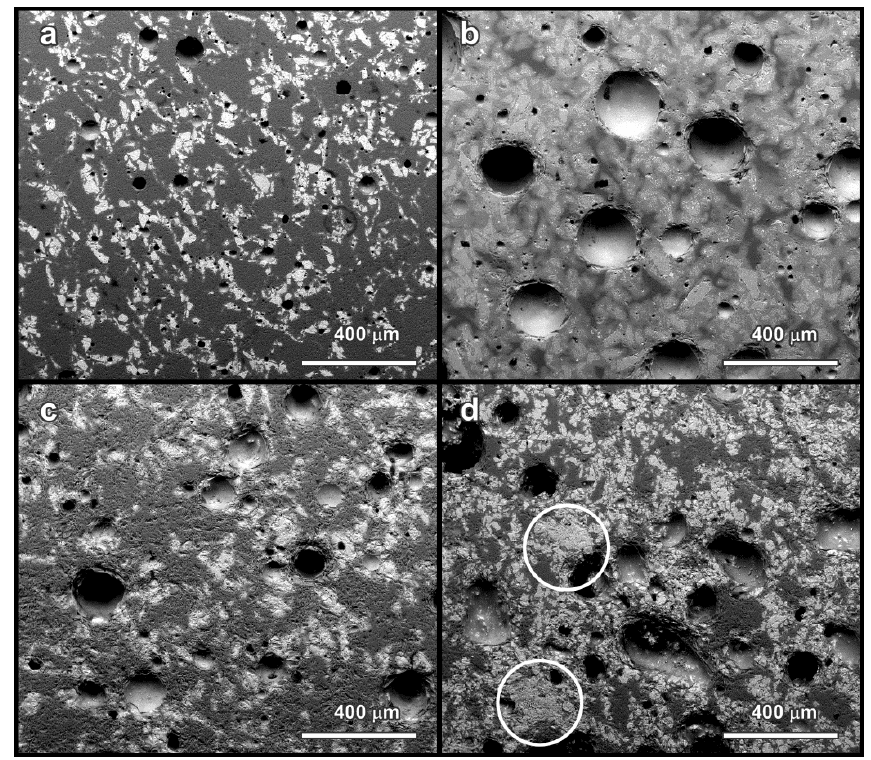
Figure 3. SEM micrographs of selected glass ceramics (polished surfaces of bending bars, cut from rectangular tiles): ( a ) 25 wt% S1, 900 °C; ( b ) 50 wt% S1, 1000 °C; ( c ) 25 wt% S2, 900 °C; ( d ) 50 wt% S2, 1000